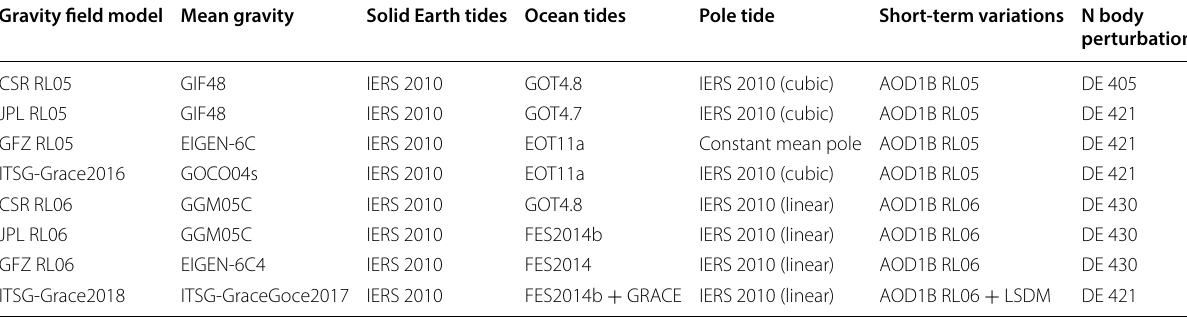
Table 1 Background models used within the RL05 and RL06 GRACE gravity field processing Gravity field model Mean